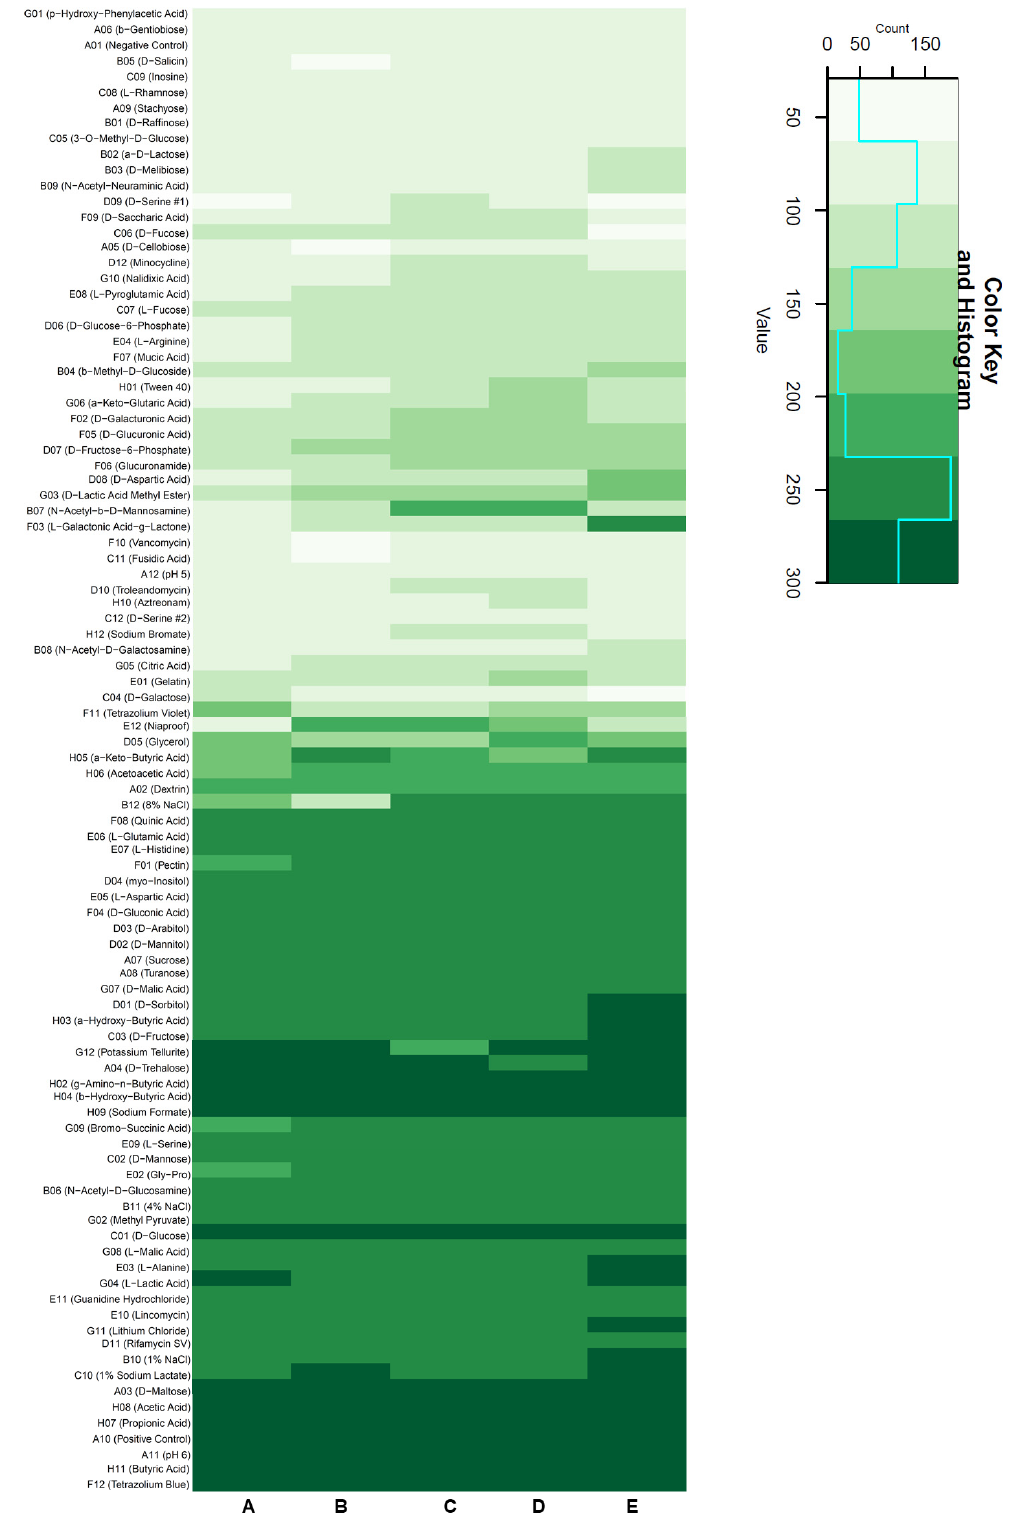
Figure 3. Heat map of BIOLOG Gen III MicroPlate analysis. This assay employs tetrazolium dye to measure the respiration of a standardized cell suspension, where stronger respiration leads to higher coloration. Darker shades of green correspond to stronger measured respiration. The cyan line in the legend shows the count for each shade in the dataset. Each tested compound was added in standardized amounts to a defined minimal medium. ( A ) DSM 65, ( B ) DSM 11104, ( C ) DSM 11073, ( D ) DSM 11072, and ( E ) DSM 2944 T